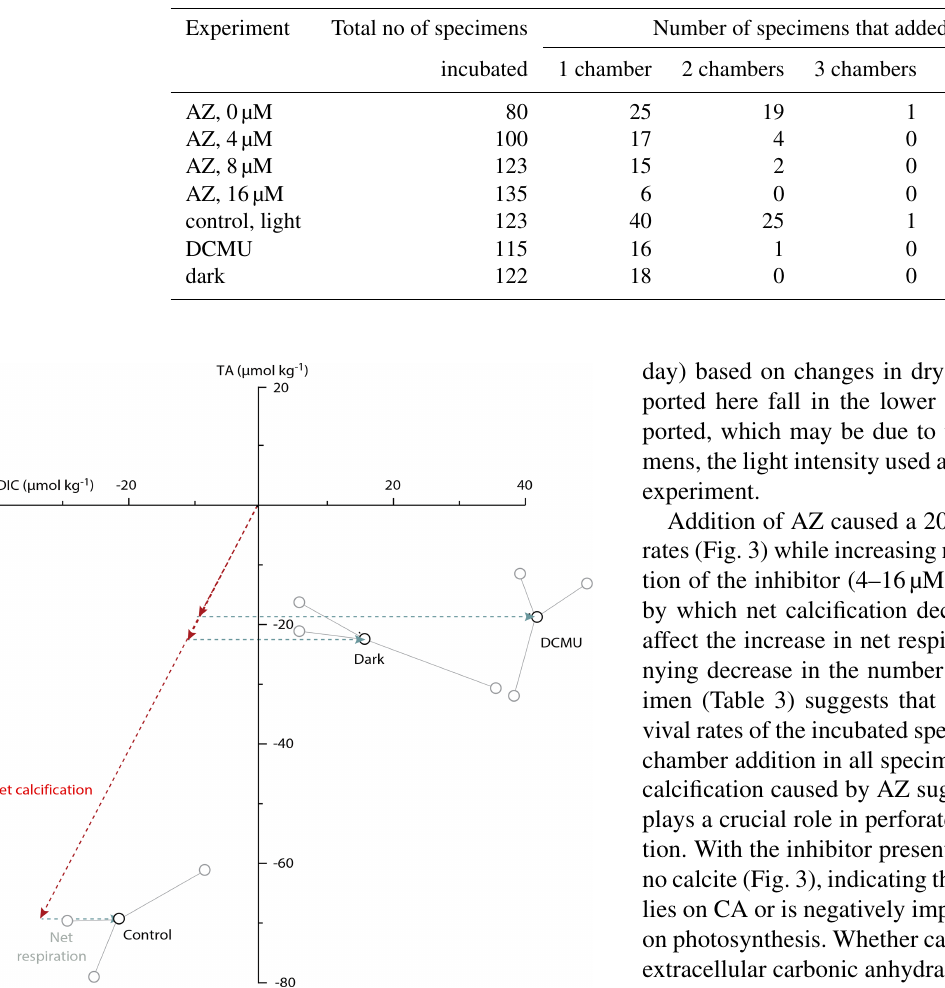
Table 3. Number of chambers added per specimen for each treatment.